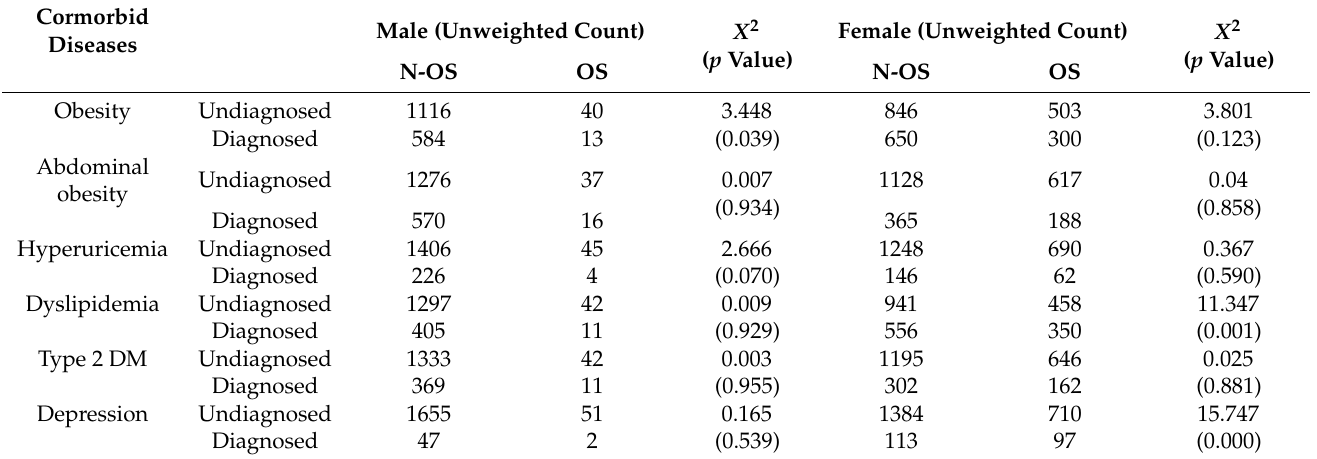
Using the Complex Samples Crosstabs procedure, a cross-tabulation of osteoporosis frequency based on comorbid diseases was performed. The odds ratios, and Chi-Square ratios ( χ 2 ) were computed. As shown in Table 2, the male subjects showed a statistically sig- nificant obesity and a negative dependency was observed ( χ 2 = 3.448, p = 0.039). In female subjects, the positively correlated values included dyslipidemia ( χ 2 = 11,347, p = 0.001) and depression ( χ 2 = 15.747, p < 0.001). Table 2. Crosstabulation tables for osteoporosis frequency by comorbid diseases. Cormorbid